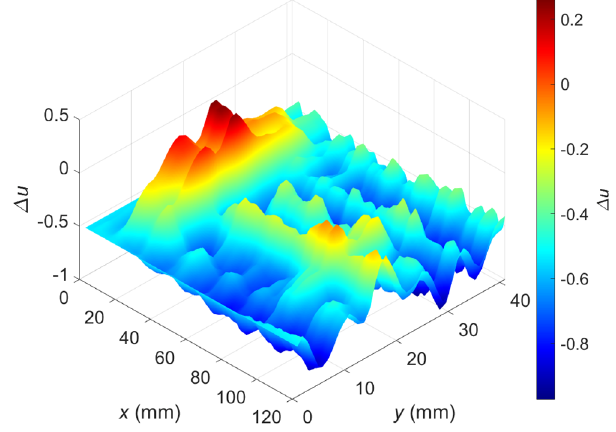
Figure 13. Two-dimensional plot of the relative voltage after background removal; excitation frequency f = 2 MHz.